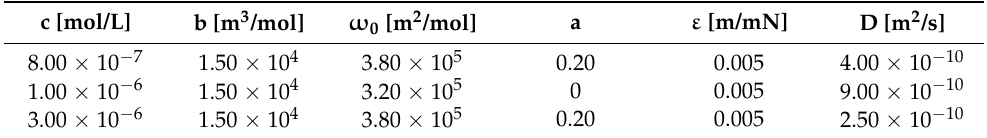
Table 8. Parameter values obtained by fitting the Frumkin adsorption model Equations (1)–(3) and the diffusion Equation (6) to the experimental data of Figure 8 as measured for equimolar solutions of NaC 12 SO 4 + C 16 TAB.